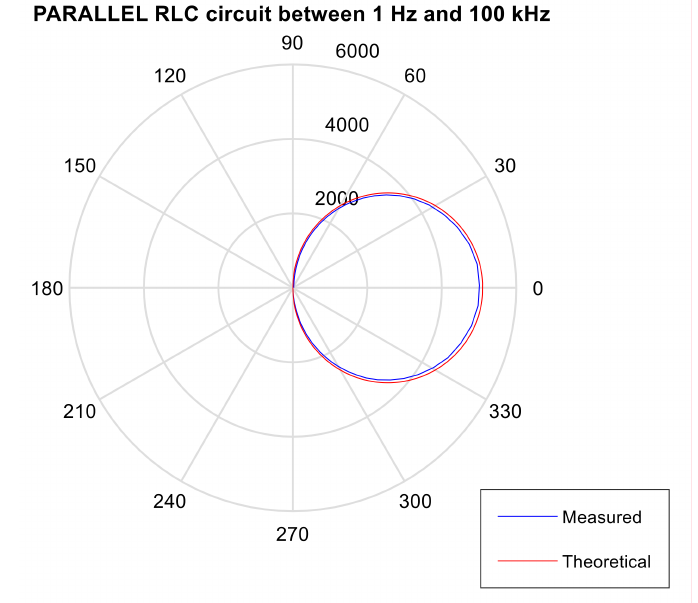
Figure 3. Polar diagram of the test with the PARALLEL RLC circuit between 1 Hz and 100 kHz. The blue values are measured and the red ones are